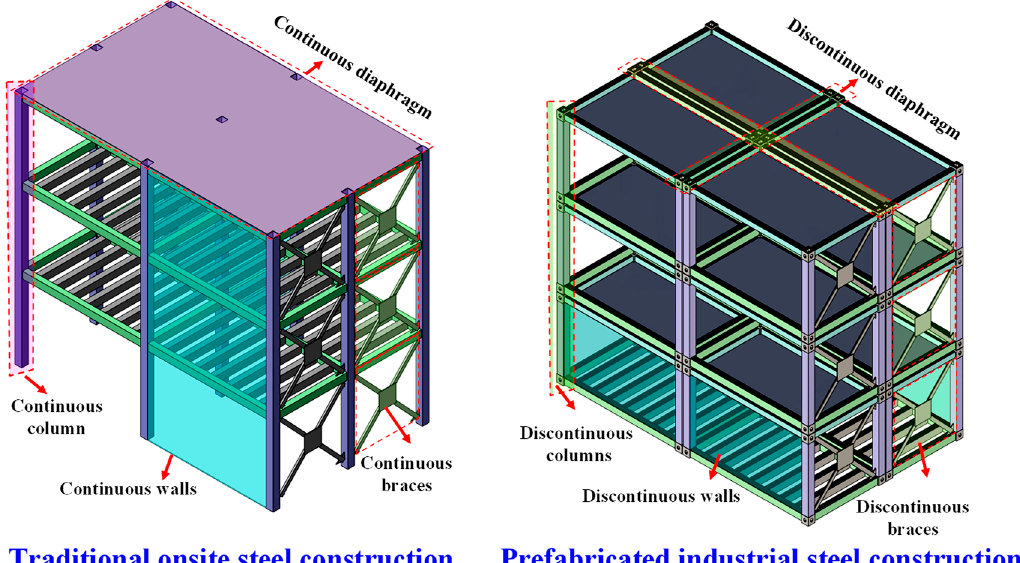
Figure 1. Traditional onsite vs. prefabricated industrial steel construction.